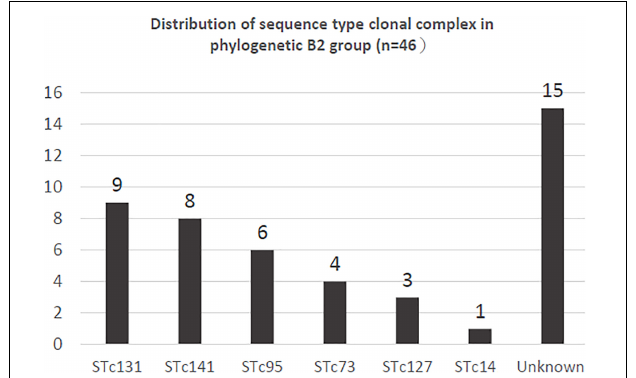
FIGURE 2 | The distribution of sequence type complexes (STc) among the 46 phylogenetic group B2 E. coli isolates in this study.